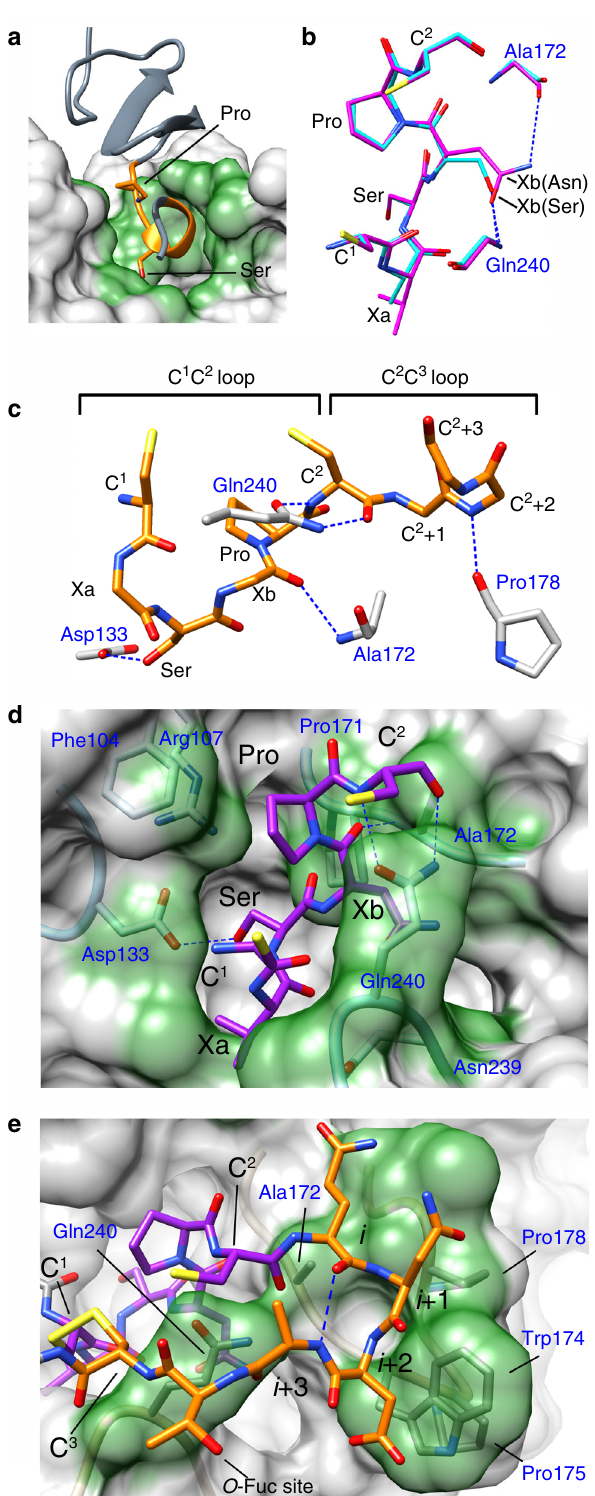
Fig. 2 Recognition of the C 1 C 2 and C 2 C 3 loops. a The C 1 C 2 loop ( orange ) is buried in POGLUT1. b Comparison of the C 1 XSNPC 2 (hEGF12 complex; magenta ) and C 1 XSSPC 2 (hF7EGF1 complex; cyan ) motifs, showing the Xb (Asn/Ser) sidechain hydrogen bonds. For clarity, the Ala172 and Gln240 sidechains are not shown. c The fi ve conserved hydrogen bonds. For clarity, the sidechains of variable residues are not shown. d Binding surface ( green ) of the C 1 C 2 loop ( purple ) in the POGLUT1/hEGF12/UDP complex. e Binding surface ( green ) of the C 2 C 3 loop ( orange ) in the POGLUT1/hEGF12/UDP complex. i , i + 1, i + 2, and i + 3 mark the